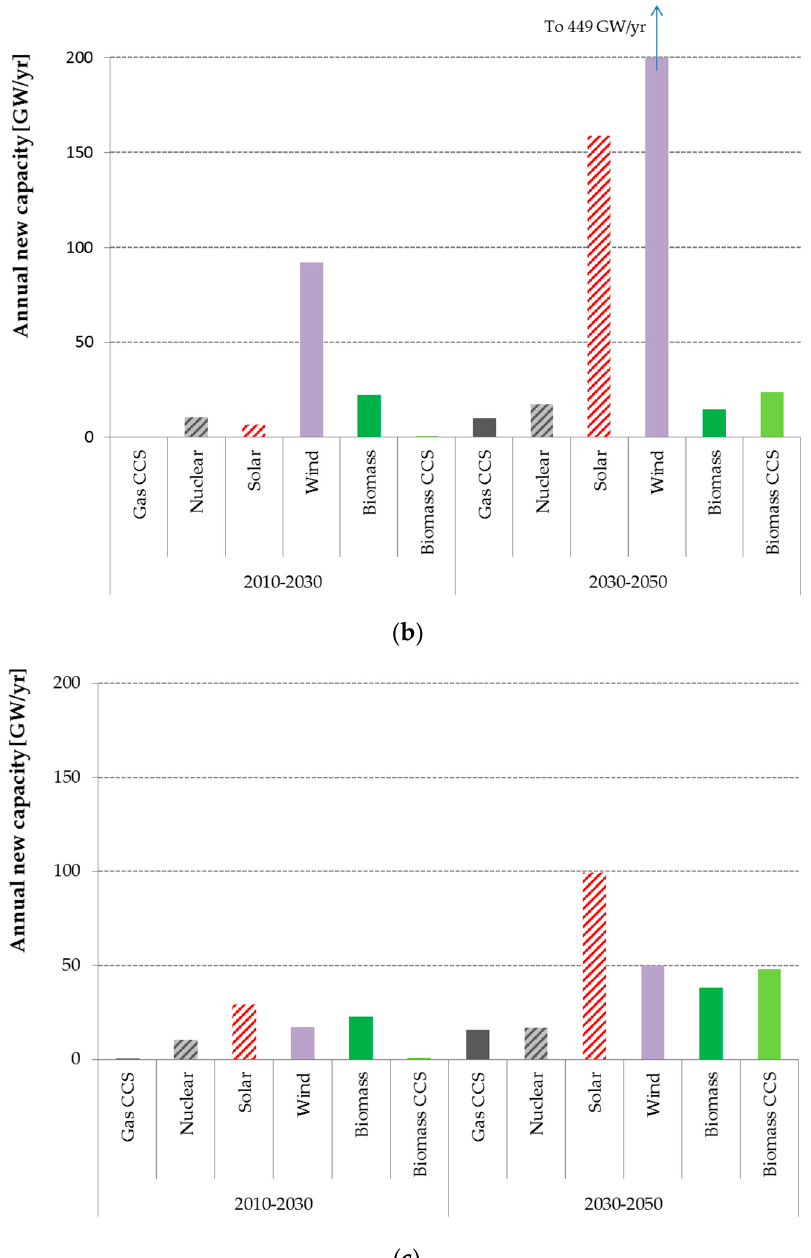
Figure 3. Average annual new installed capacity in the electricity sector (in GW/year) showing